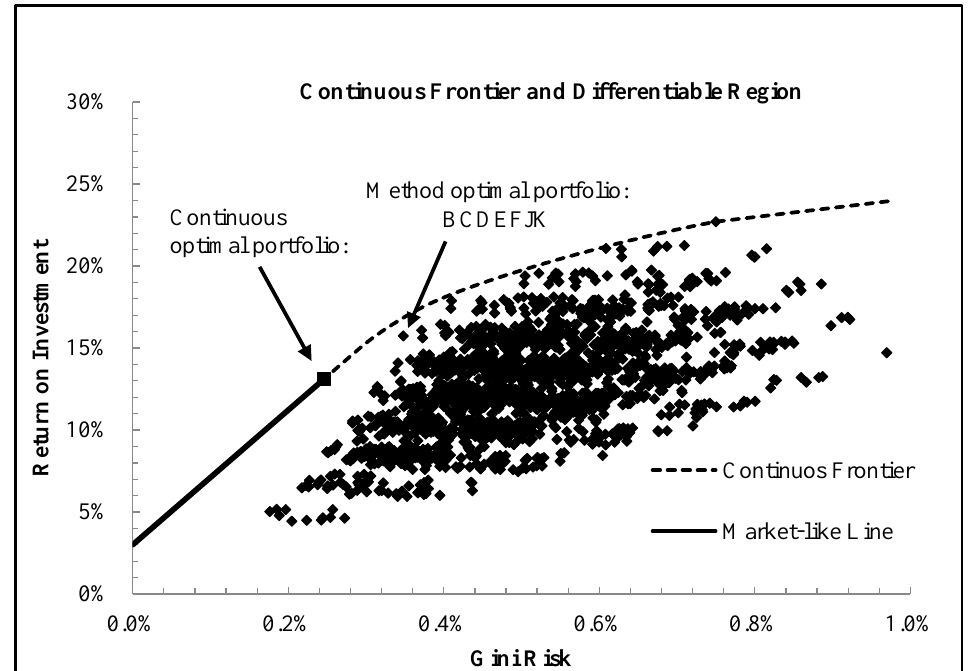
Figure 2. Continuous frontier and differentiable region.